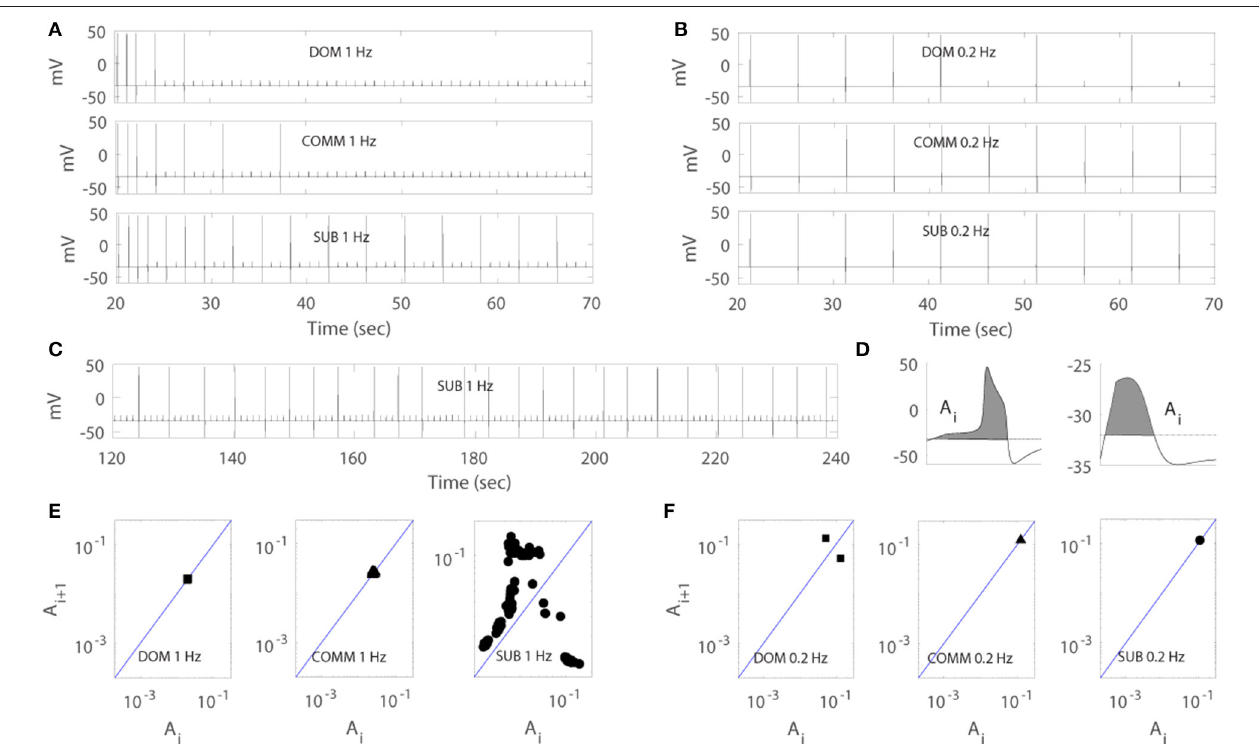
FIGURE 4 | Numerical simulation of the model for dominant-like case (DOM) (ag max = 41.5 upper panels), communal-like case (COMM) (ag max = 42.2 middle panels), and subordinate-like case (SUB) (ag max = 43.5 lower panels) under periodic inputs at 1Hz (left panels) and 0.2Hz (right panels). Membrane voltage trace in DOM (upper panel), COMM (middle panel), and SUB (lower panel) at 1Hz (A) and 0.2Hz (B) . ( C ) Irregular activity patterns of SUB at 1Hz (corresponds to E right panel). (D) Area A i under the voltage trace above the threshold (dash line) with action potential (left panel) and subthreshold (right panel). (E,F) One-dimensional return map in DOM (left panel), COMM (middle panel), and SUB (right panel) at 1Hz (E) and 0.2Hz (F)